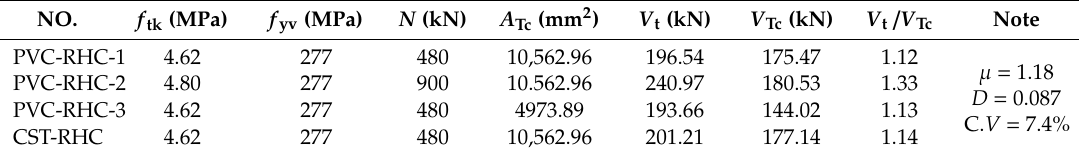
Table 8. Comparison of ultimate shear bearing capacity between the test value and calculated